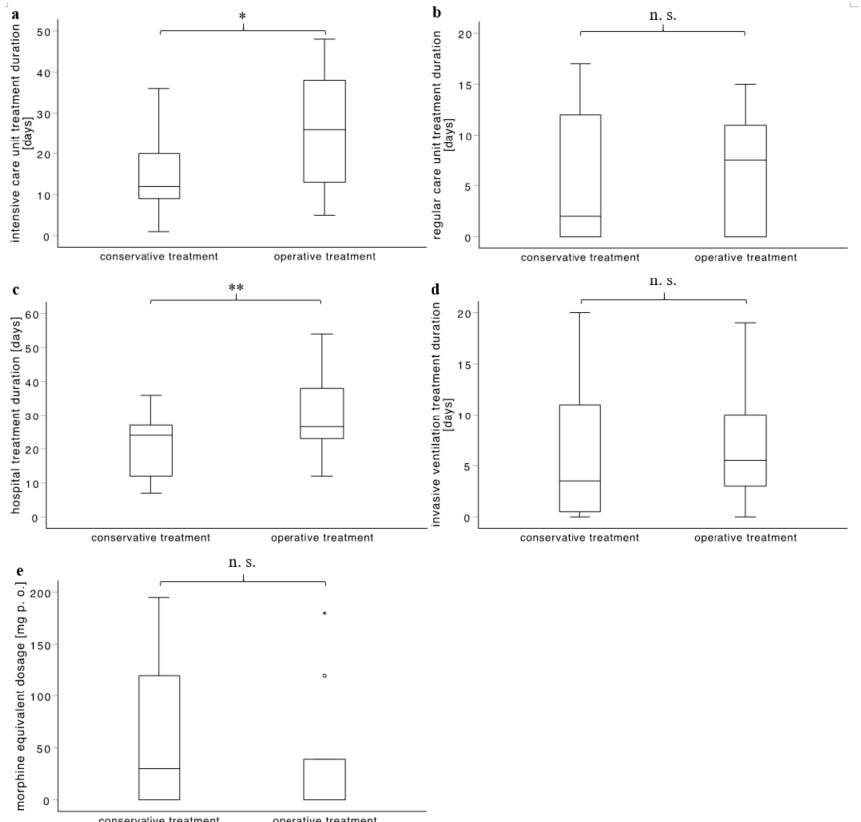
Figure 1. Overview of the outcome of the case-control matched cohort. ( a ) depicts the duration of the intensive care unit treatment duration which was 15.27 ± 12.10 and 25.18 ± 14.48 days in conservatively and operatively treated patients, respectively ( Z = − 2.308, p = 0.021). ( b ) depicts the duration of the normal ward treatment duration which was 5.64 ± 6.62 and 6.20 ± 5.85 days in conservatively and operatively treated patients, respectively ( Z = − 1.054, p = 0.292). ( c ) depicts the total hospital treatment duration which was 20.91 ± 10.34 and 30.10 ± 13.01 days in conservatively and operatively treated patients, respectively ( Z = − 2.807, p = 0.005). ( d ) depicts the duration of the invasive ventilation which was 6.25 ± 7.17 and 7.10 ± 6.14 days in conservatively and operatively treated patients, respectively ( Z = − 1.192, p = 0.233). ( e ) depicts the pain medication at the time of hospital discharge as morphine equivalent dosage. This was 61.36 ± 67.23 mg and 39.67 ± 65.65 mg in conservatively and operatively treated patients, respectively ( Z = -0.845, p = 0.398). * p ≤ 0.05 , ** p ≤ 0.01 , n. s. not significant. During the ICU stay, patients conservatively treated stayed for 6.25 ± 7.17 days (range 0–20.0 days) and patients operatively treated stayed for 7.10 ± 6.14 days (range 0–19.0 days). The differences between groups did not significantly differ ( Z = − 1.192, p = 0.233). At the time of hospital discharge, conservatively treated patients needed an equivalence of 61.36 ± 67.23 mg (range 0–195.0 mg), while operatively treated patients needed an equivalence of 39.67 ± 65.65 mg (range 0–180.0 mg) oral morphine as a pain medication. The differences between groups did not reach significance ( Z = − 0.845, p = 0.398). A total of four patients (36.4%) out of the conservatively treated and six patients (54.5%) out of the operatively treated group received antibiotic treated due to the clinical and radiographic diagnosis of a pneumonia. This difference did not reach significance ( p = 0.687).